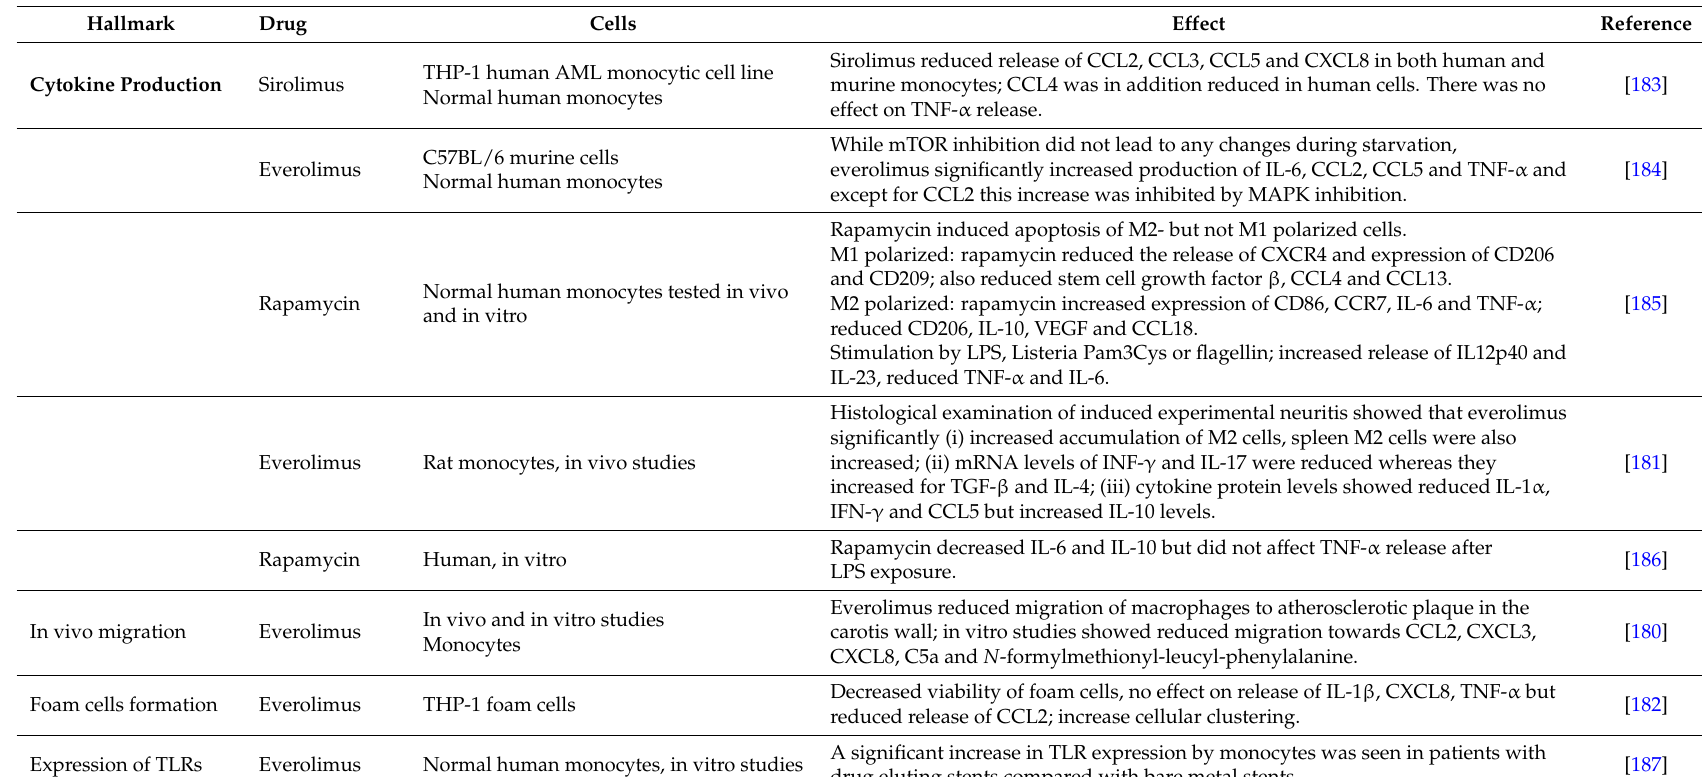
Table 7. The effect of mTOR inhibition on various biological characteristics of human